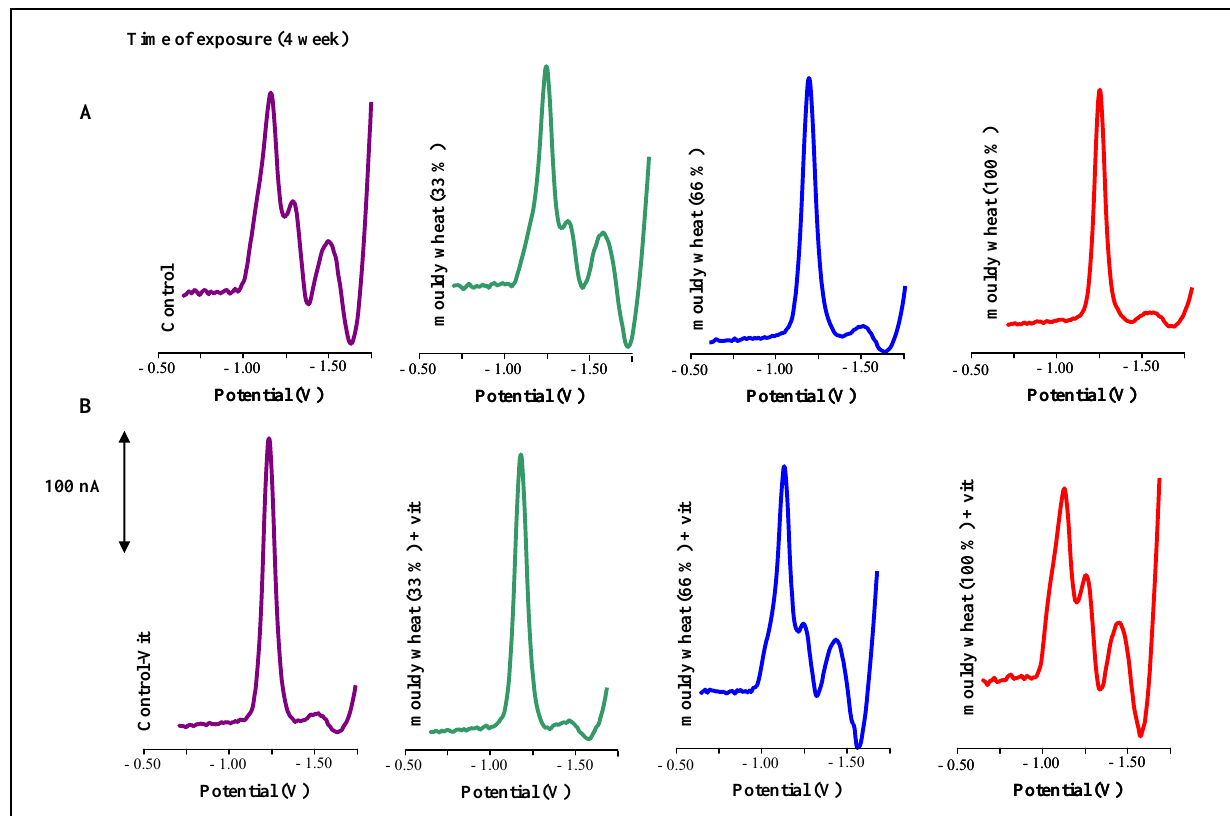
Figure 7. Typical DP voltammograms of the extracts obtained from livers of rats. The extracts were prepared according to protocol mentioned in the “Experimental” section; number of measurements =